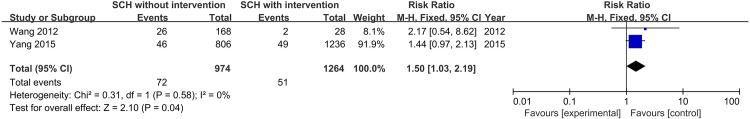
Forest plots of the prevalence of miscarriage risk in SCH without intervention compared to SCH with treatments.